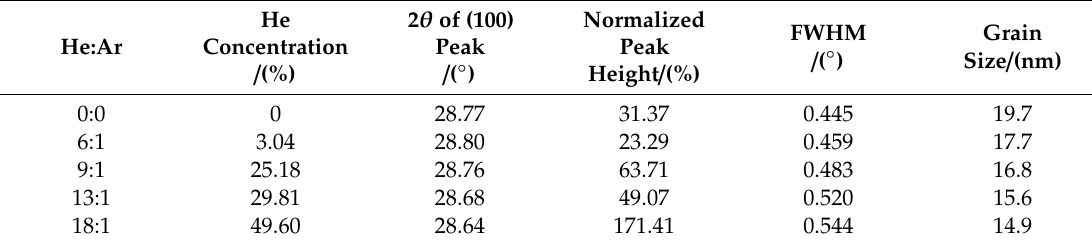
Table 2. The (100) diffraction peak of Er films with different He concentrations.